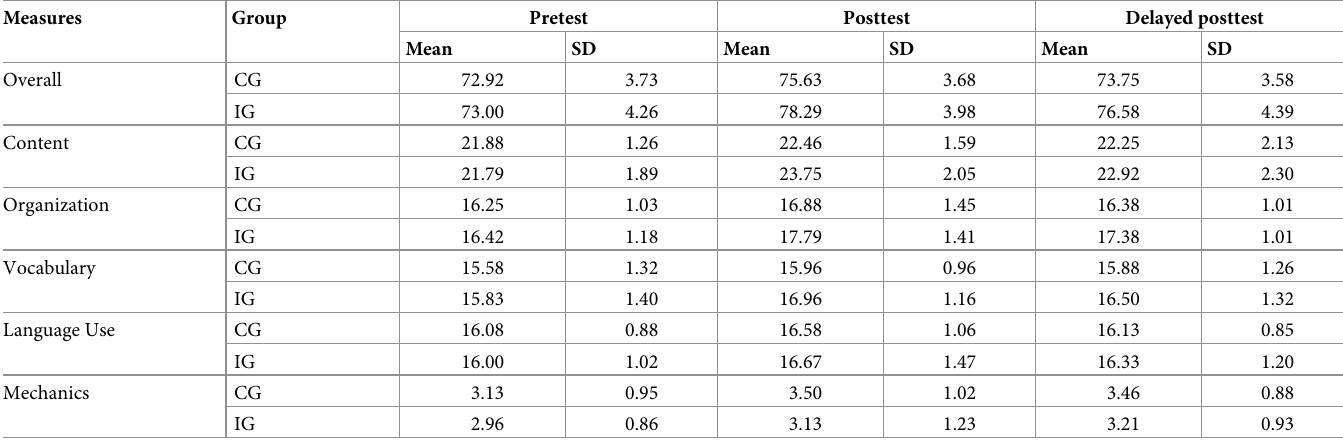
Table 2. Descriptive statistics for holistic and analytic scores of overall writing quality across